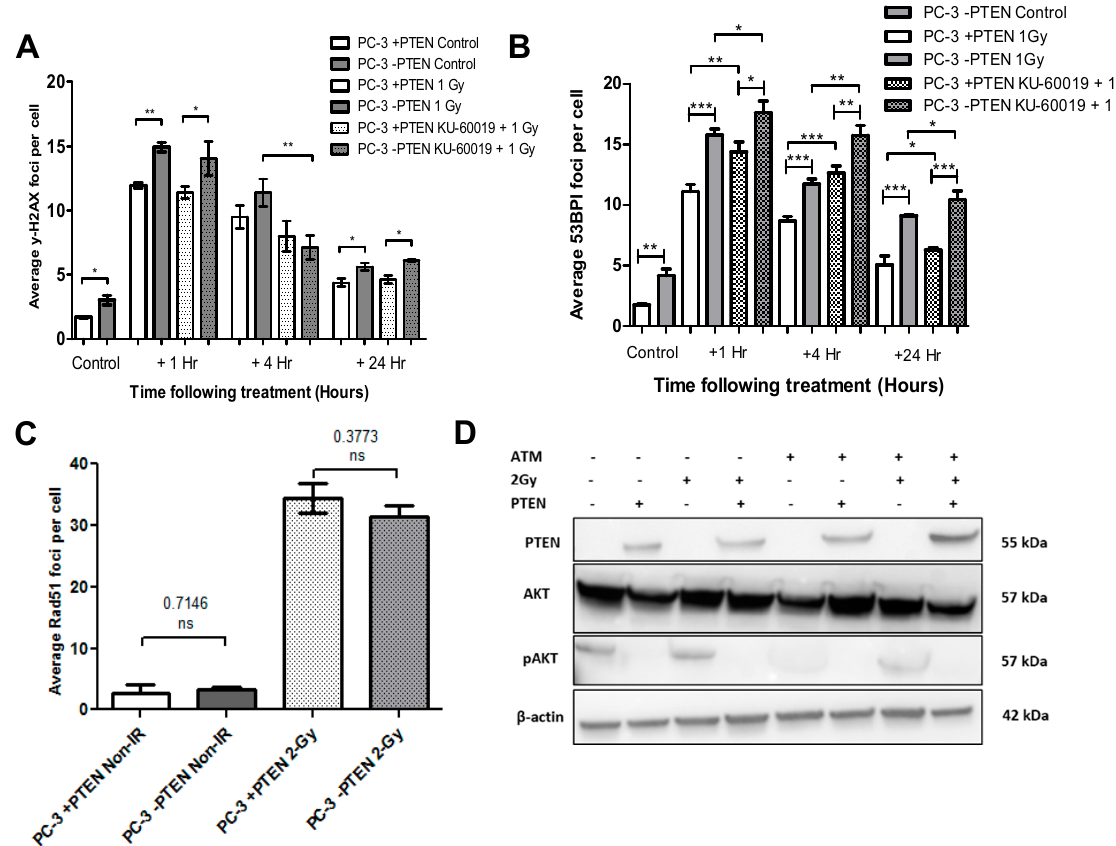
Figure 4. Dependency of DNA damage yields on PTEN status and combinations of radiation with KU-60019. ( A , B ) Levels of DNA damage in PC-3 PTEN isogenic cell models following KU-60019 and IR alone or in combination. Mean γ -H2AX and 53BP1 foci per cell was plotted at 1, 4, and 24 h post-treatment with 1 Gy IR or 1 Gy + 1 µ M KU-60019. Differences between two groups were compared by using a two-sample student’s t -test (one asterisk (*), p < 0.05; two asterisks (**), p < 0.01; three asterisks (***), p < 0.001). ( C ) Mean Rad51 foci per cell in PC-3 PTEN isogenic cell models basally and 1 h following 2 Gy ionising radiation. Differences between th two groups were compared by using a two-sample student’s t -test. NS denotes a non-significant difference. ( D ) Western blot analysis showing basal expression levels of PTEN, Akt, and pAKT in PC-3 +PTEN and PC-3 –PTEN models.